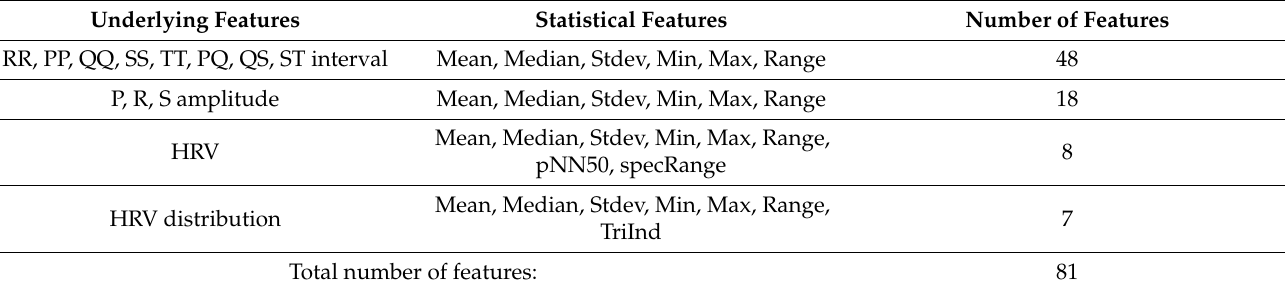
Table 3. AuBT’s ECG